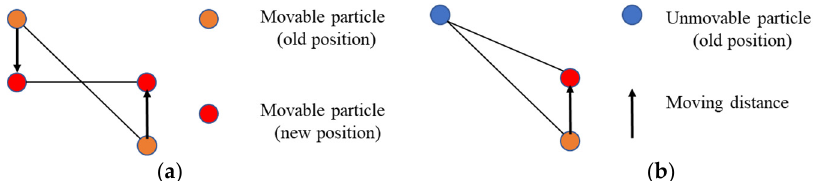
Figure 4. Schematic diagram of hole constraint. ( a ) Both particles can move; ( b ) only a single particle can move [29].